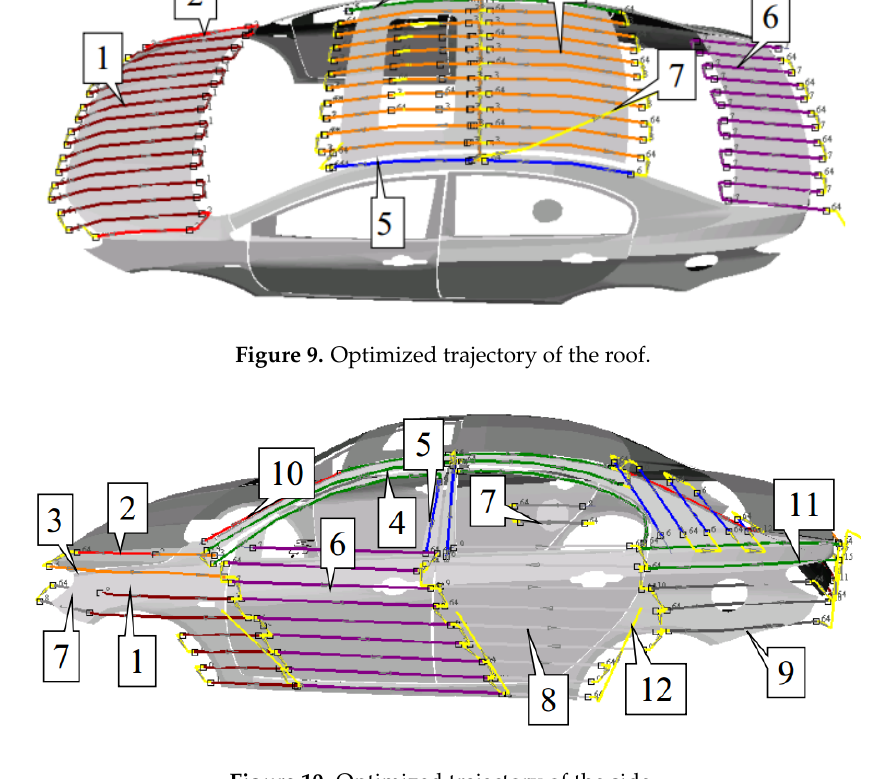
Figure 10. Optimized trajectory of the side.